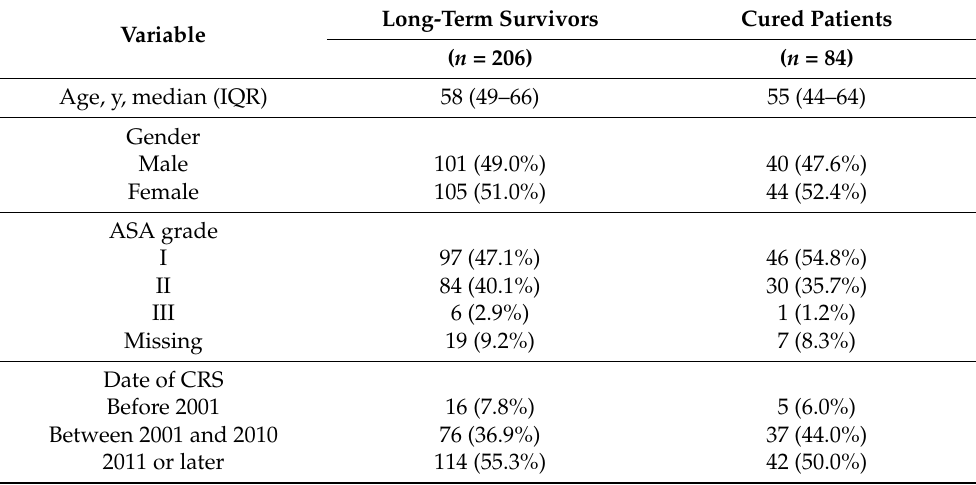
Table 1. Baseline characteristics.